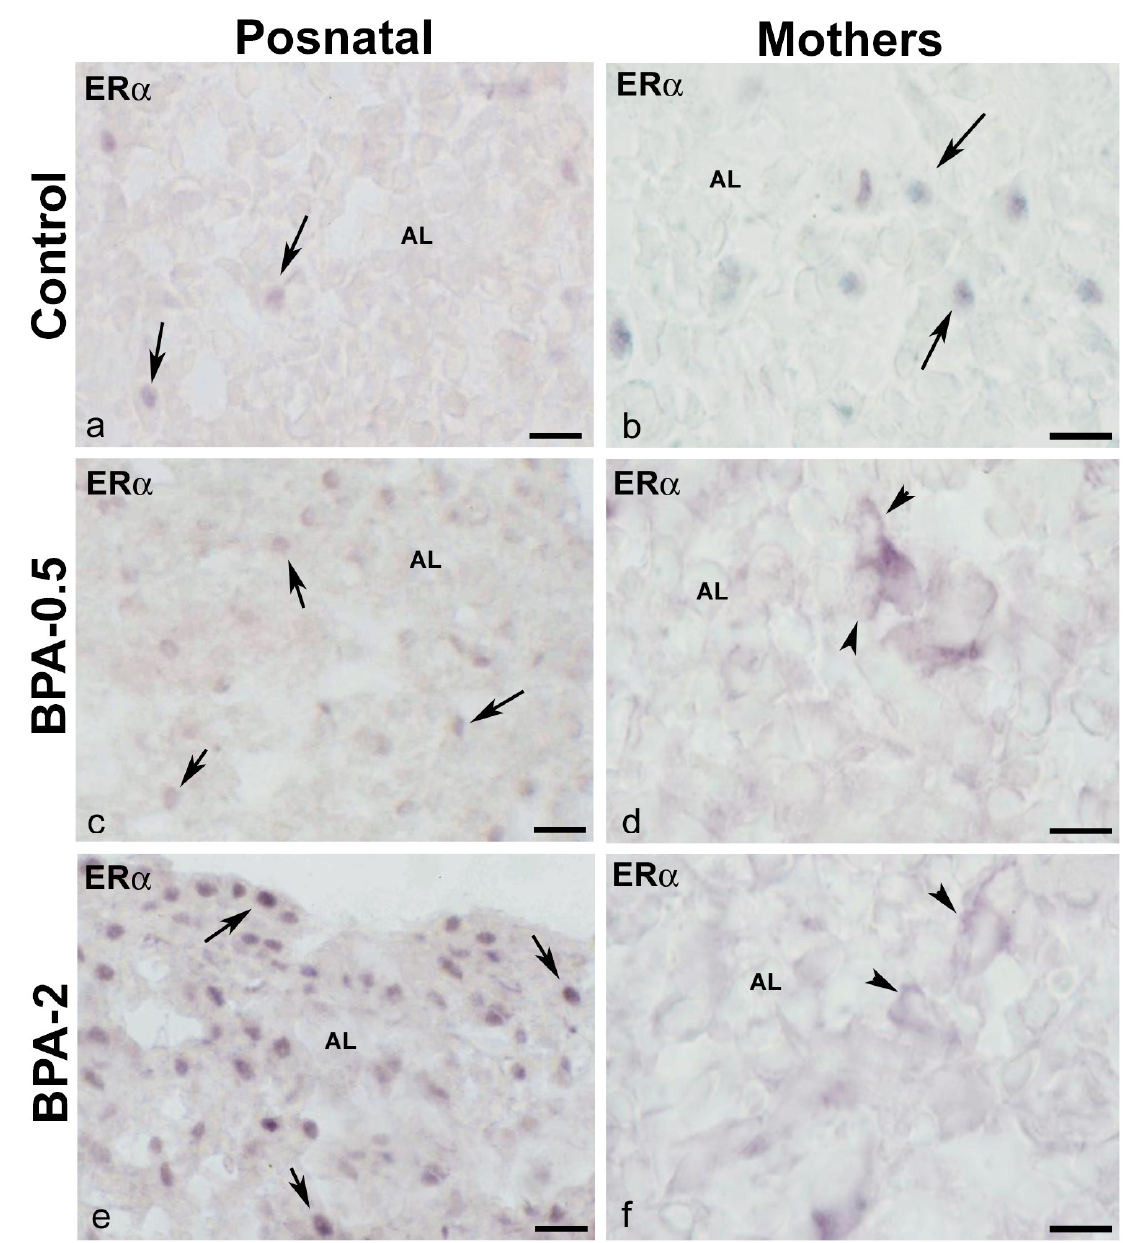
Figure 7. ER α immunoreactivity in offspring and the mother’s pituitary gland . Representative images of the pituitary gland in offspring at the first week of postnatal life ( a , c , e ) and mothers after weaning/lactation ( b , d , f ) showing the presence of ER α -ir cells in the anterior lobe in the three experimental groups. The nuclear location of ER α immunoreactivity in offspring and control mothers is indicated with arrows, while the cytosolic location in BPA-treated mothers is indicated with arrowheads. AL: anterior lobe. Scale bars: ( a , c , e ): 25 µm and ( b , d , f ): 20 µm.